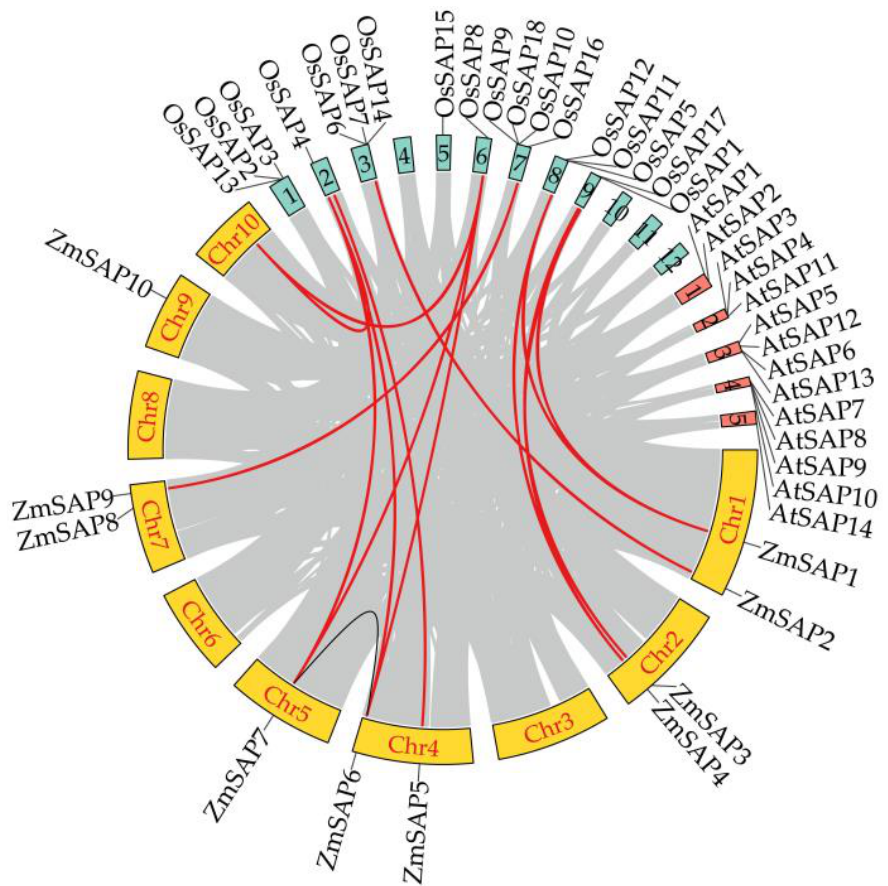
Figure 3. Chromosome localization and collinearity analysis of SAP s in maize. The inner black line represents the paralogous pair of ZmSAPs . The inner red line indicates collinearity within species of SAP genes between maize and rice. The yellow blocks represent 10 chromosomes of maize, the green blocks represent 12 chromosomes of rice, and the red blocks represent 5 chromosomes of Arabidopsis .